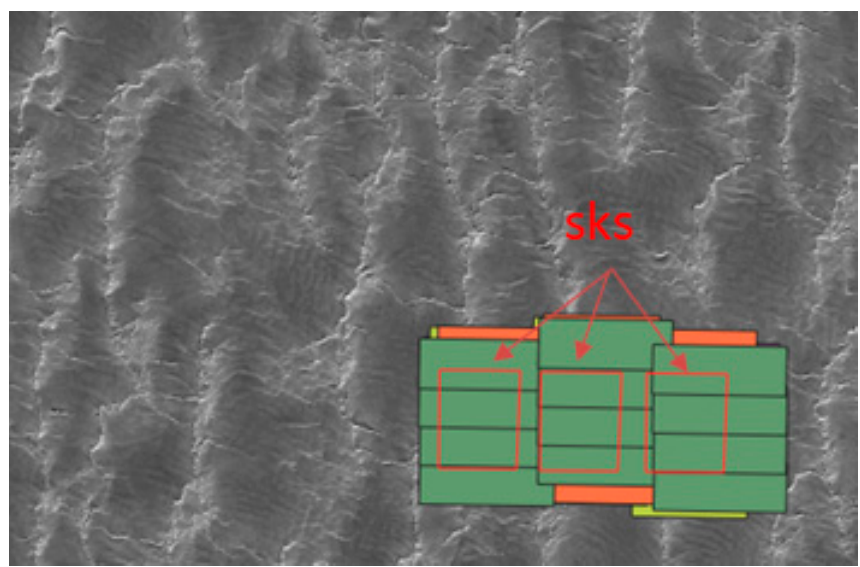
Figure 7. The SkySat scene footprint over the Libya site and the ROIs per SkySat (sks) camera. Image data numbers (DNs) were transformed into TOA values using the coefficients given in the metadata, and the coefficients were compared with the results by using the DN-to-TOA reflectance equations. The in-band solar irradiance data were also given by the vendor (Thuillier spectrum). The Sentinel-2A (S2A) BOA values with respect to scattering angle are presented in Figure 8. The scattering angle was calculated using Equation (7). The linear correspondence between the scattering angles and the BOA measurements was used to compute the expected S2A BOA measurements for a given SkySat scattering angle. The spectral model used here is shown in Figure 9. One set of ROIs with footprints within the SkySat frame images was selected for this purpose.